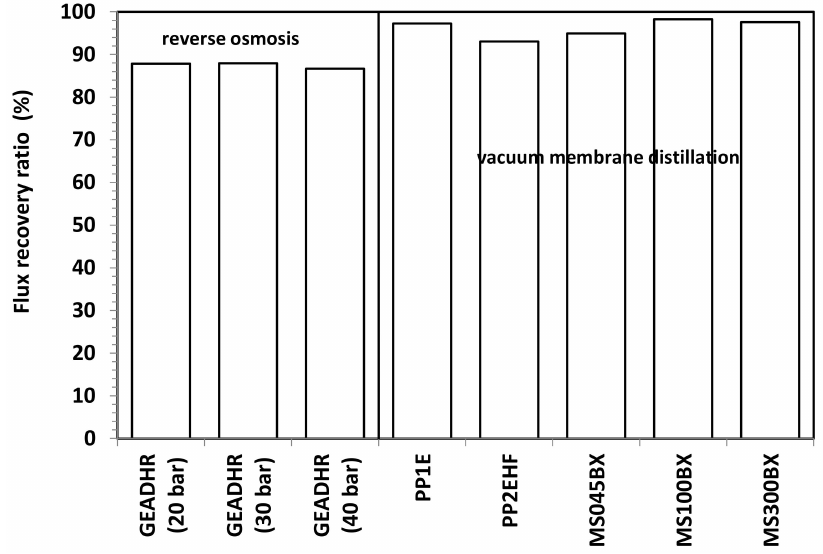
Figure 11. Flux recovery ratio vs. operating pressure of RO and VMD